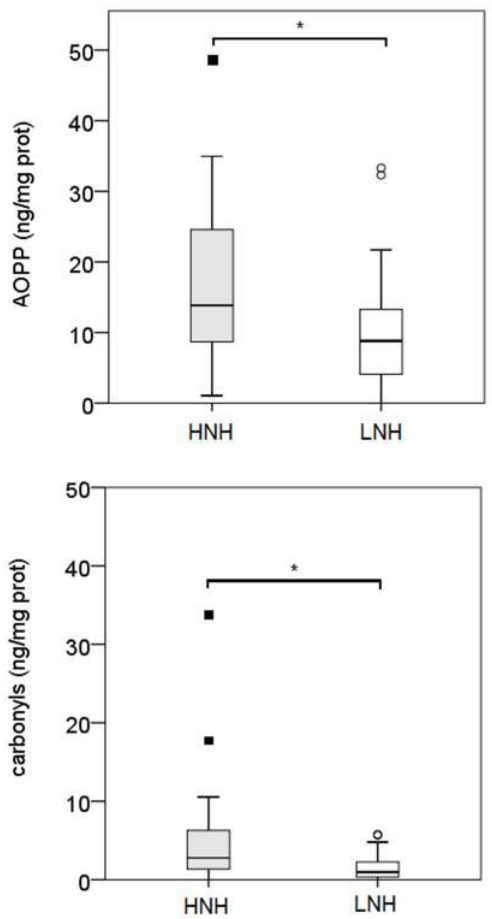
Figure 2. AOPP and carbonyl group concentrations in the uterine horn lavage samples obtained from the uterine horns displaying the higher and lower neutrophil percentages (HNH) and (LNH), respectively. The asterisks (*) indicate statistically significant differences ( p < 0.05; Mann-Whitney test, SPSS 24.0).